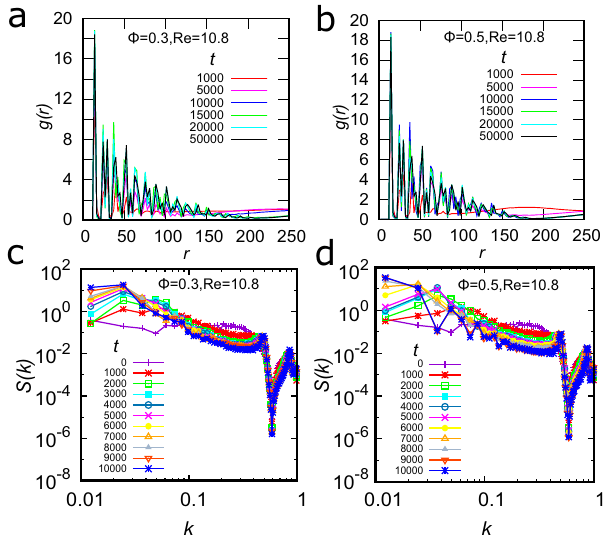
Fig. 10 Analyses of structural evolution without the nonlinear convective term. Here we do not distinguish the rotational direction of disks for g ( r ), whereas we distinguish it for S ( k ), as before. a , b The t -dependences of g ( r ) for an off-symmetric composition (OSM) ( Φ = 0.3, Re = 10.8) and a symmetric composition (SM) ( Φ = 0.5, Re = 10.8), respectively. c , d The t - dependences of S ( k ) for OSM ( Φ = 0.3, Re = 10.8) and SM ( Φ = 0.5, Re = 10.8),